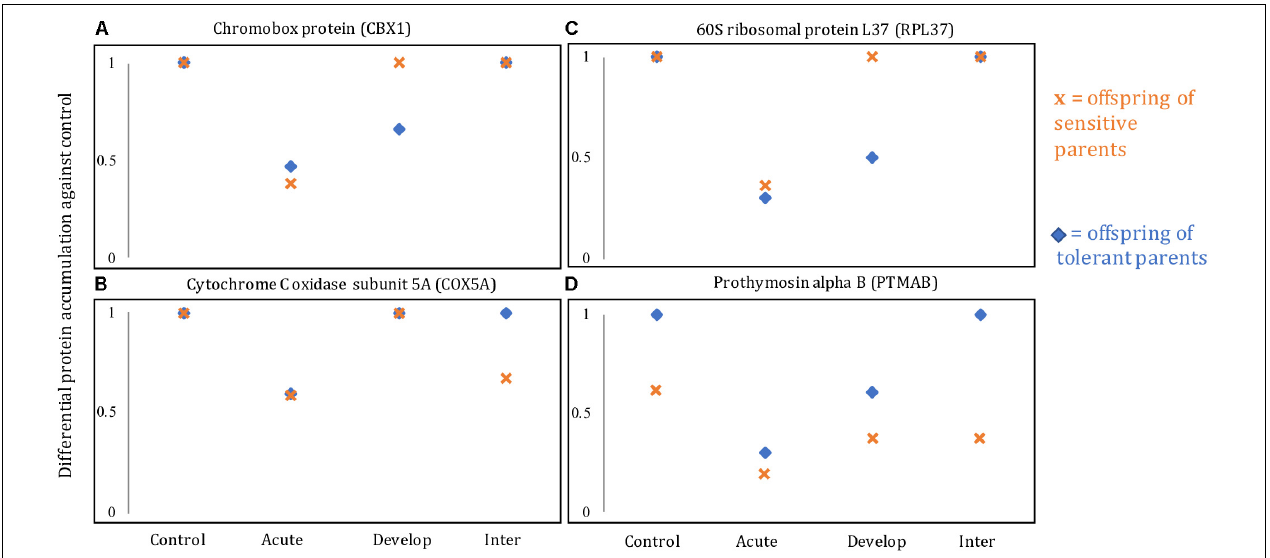
FIGURE 4 | Levels of relative protein accumulation in the offspring of sensitive and tolerant parents of four different proteins: (A) chromobox protein homolog 1-like (CBX1), (B) cytochrome C oxidase subunit 5A, mitochondrial-like (COX5A), (C) 60S ribosomal protein L37 (RPL37), and (D) prothymosin alpha B-like (PTMAB). Control, Acute, Develop, Inter refer to the control, acute, developmental and inter-generational treatment,